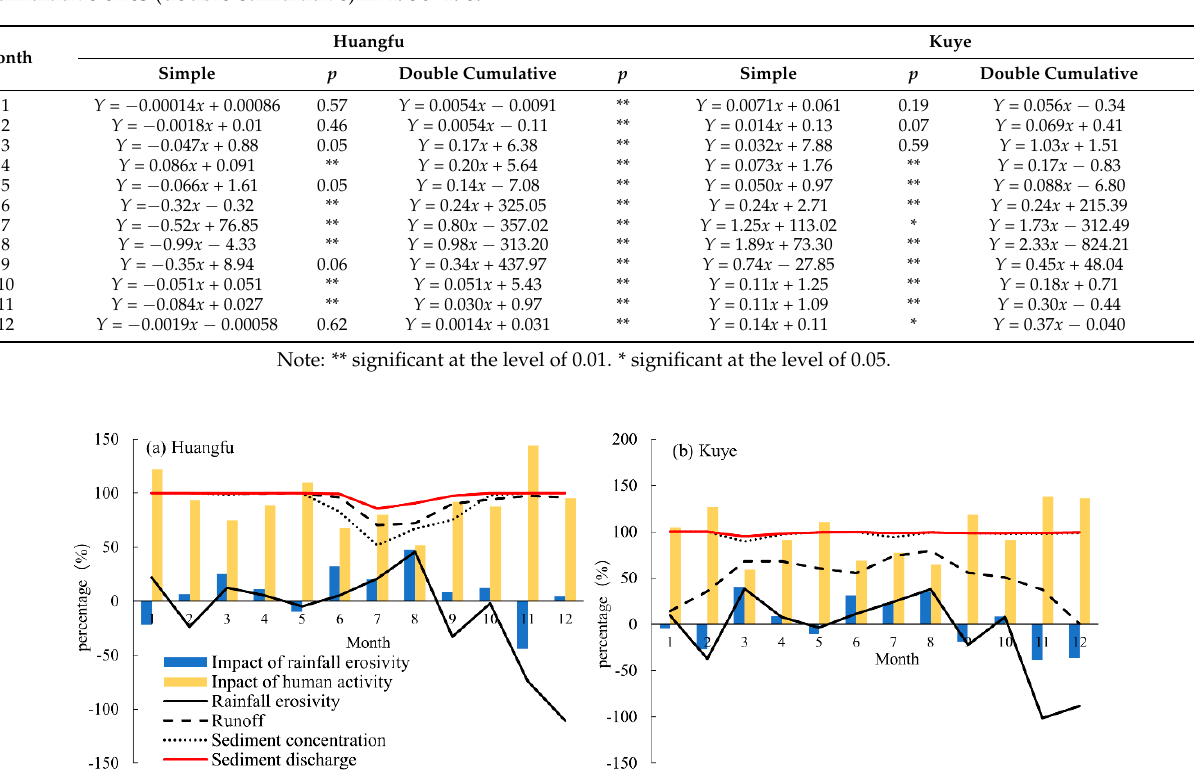
Table 6. Regression relationships between monthly sediment discharge and monthly rainfall erosivity (simple) and between cumulative ones (double cumulative) in 1956–1989.